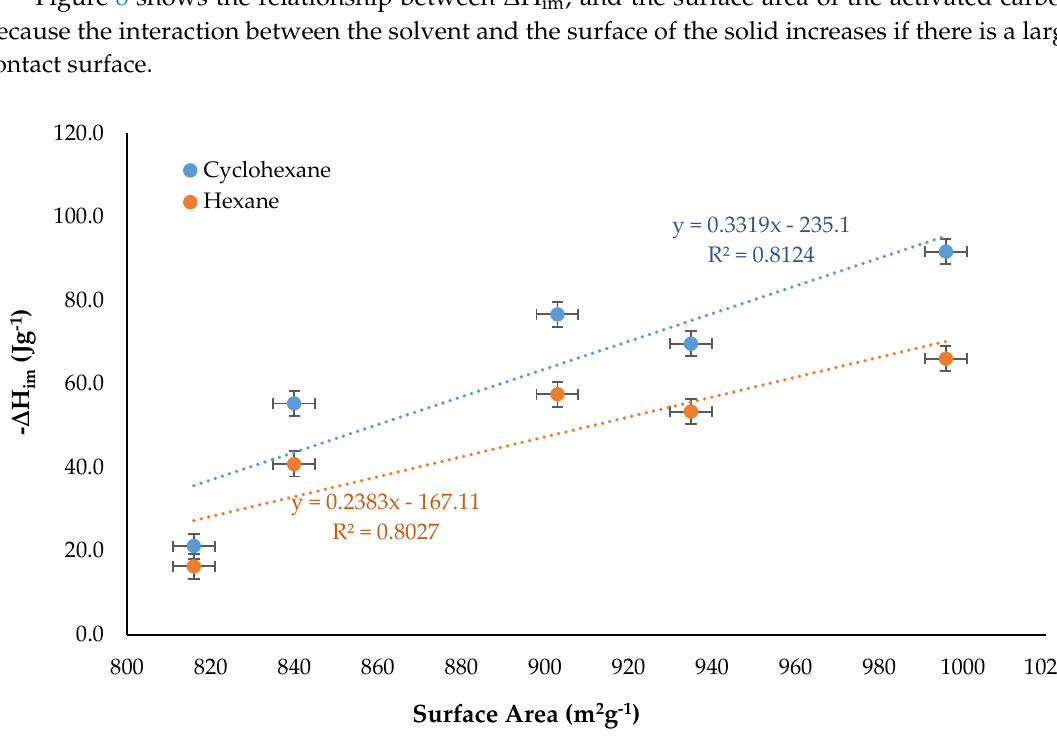
Figure 8. Immersion enthalpy in function of the surface area of the activated carbons.